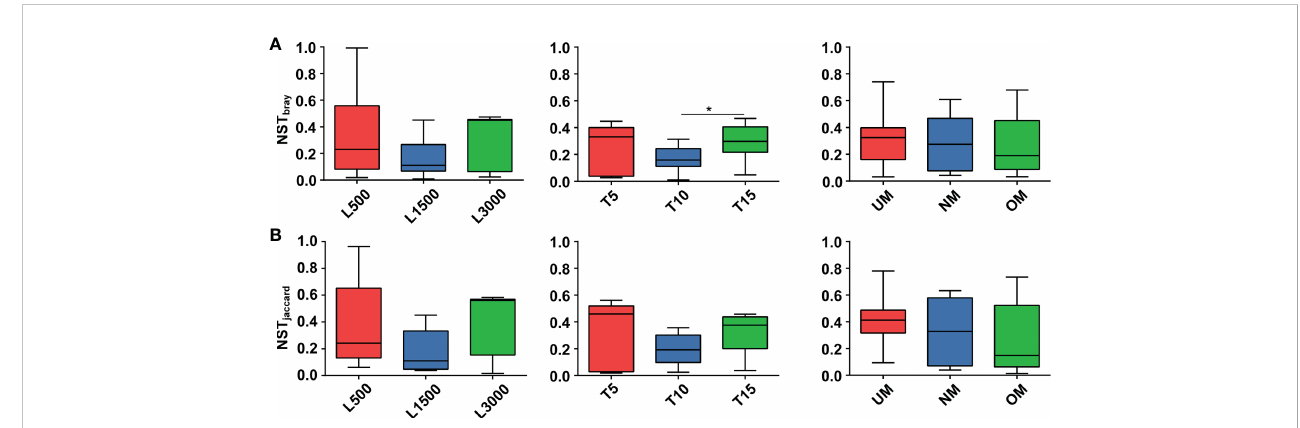
FIGURE 6 Comparisons of NST values among different treatment groups based on Bray-Curtis (A) and Jaccard (B) dissimilarity. Asterisk on the boxes indicate signi fi cant difference (* p < 0.05 Tukey post-hoc test) among